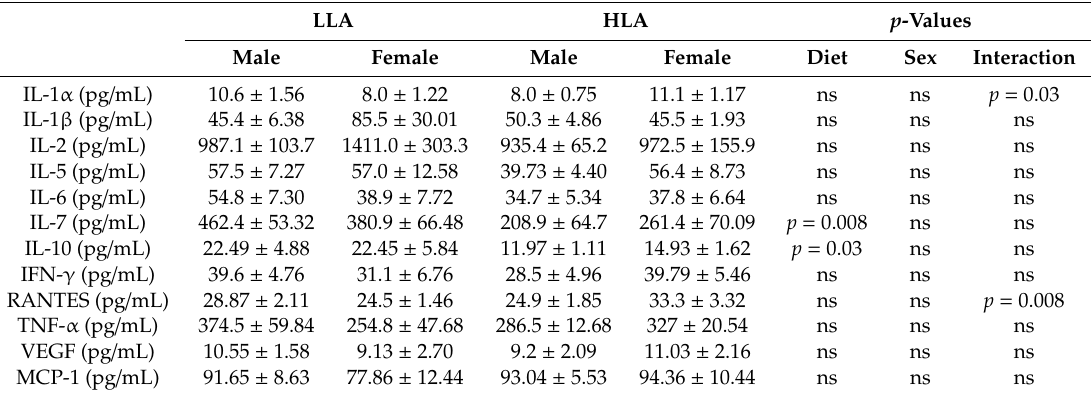
Table 4. E ff ect of a maternal diet high in linoleic acid on cytokines, chemokines, and growth factors in the labyrinth zone of the rat